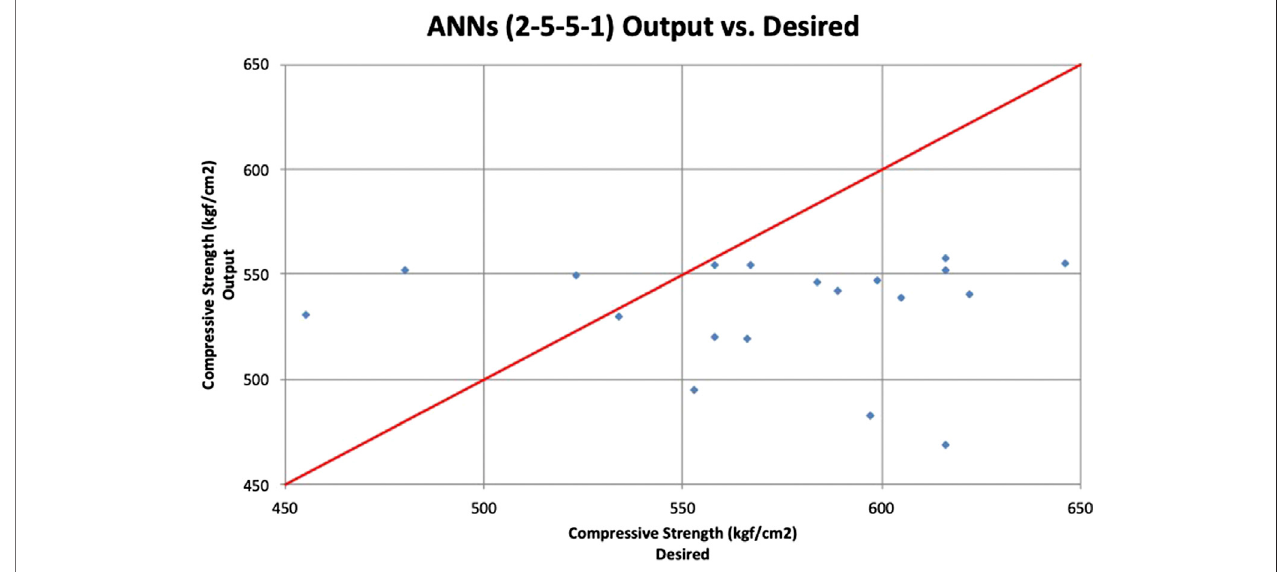
FIGURE 10 | ANN model (2-5-5 – 1) scatterplot.